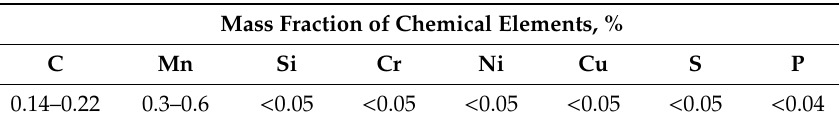
Table 1. Chemical composition of St3 carbon steel